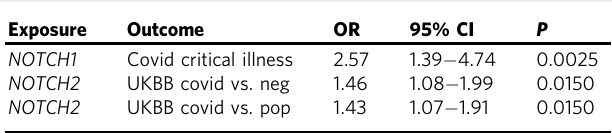
Only the associations that reached nominal signi fi cance ( P <0.05) are